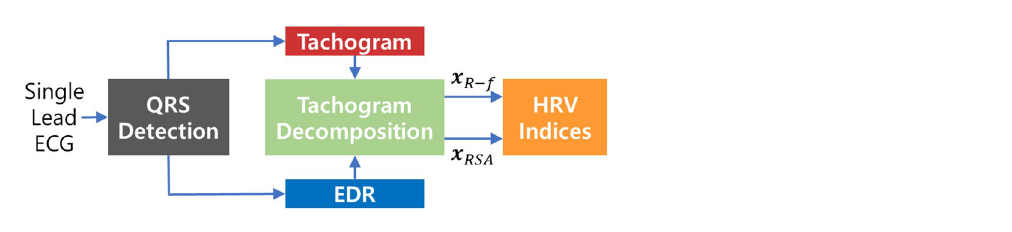
Figure 2. Overall structure of the proposed